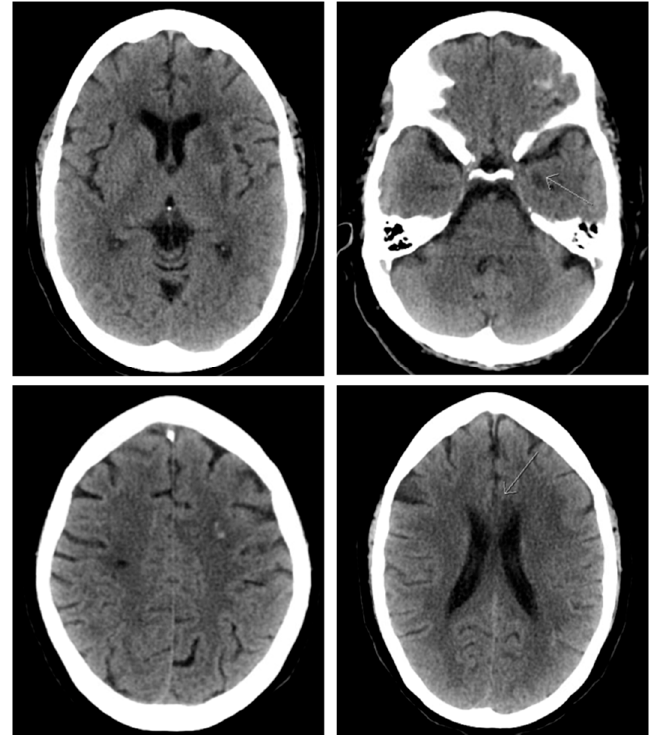
Figure 3. Non-contrast head CT showing multiple areas of small petechial hemorrhage 24 hours following the second mechanical thrombectomy.